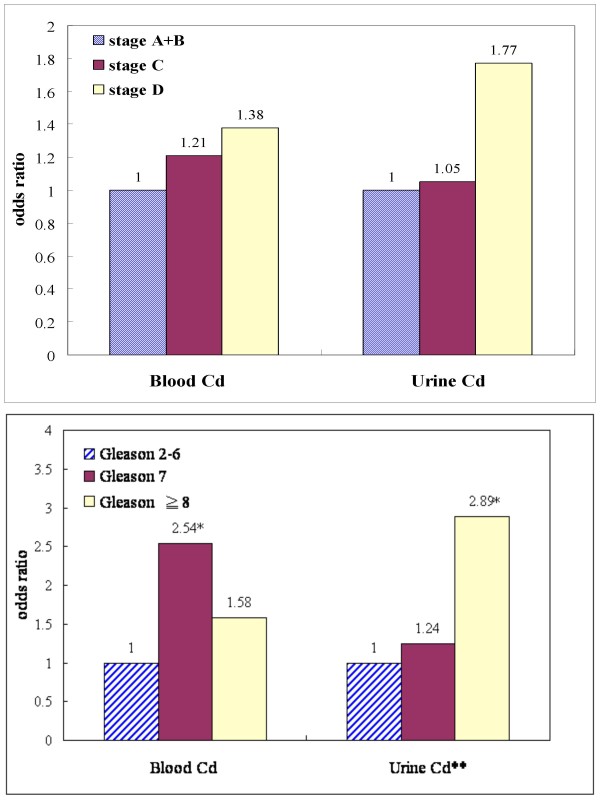
Odds ratio (OR) by stage (C, D vs A+B) and Gleason score (≥ 7 vs. 2-6) of association of prostate cancer with cadmium levels in urine and blood§ (*p < 0.05; **p for trend = 0.04). § Using the median level of cases as the cutoff value for risk determinations, 0.87 μg/l for blood cadmium and 1.12 μg/g creatinine for urine cadmium.